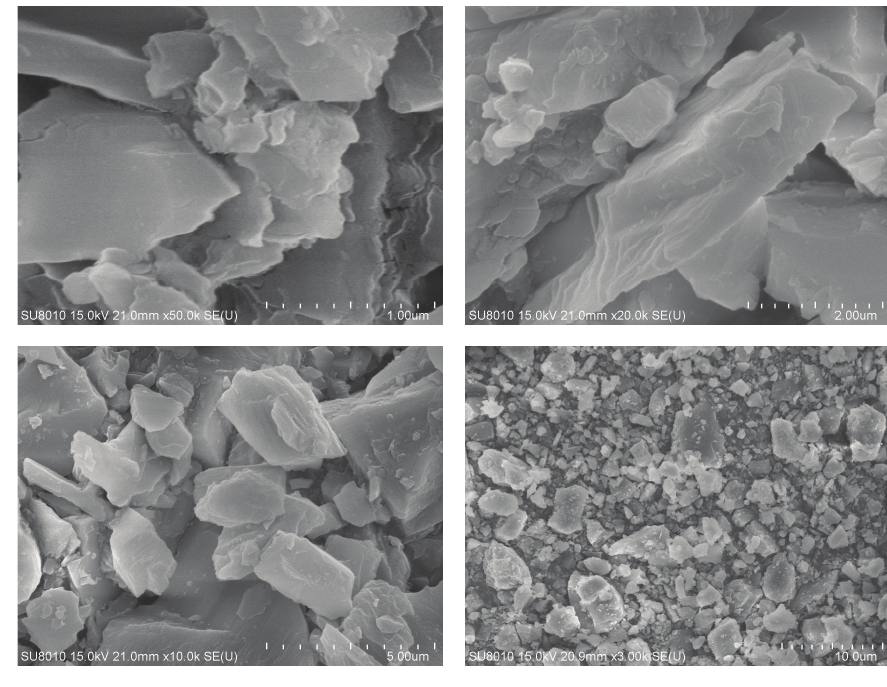
Figure 3: FESEM micrographs of FSPA.